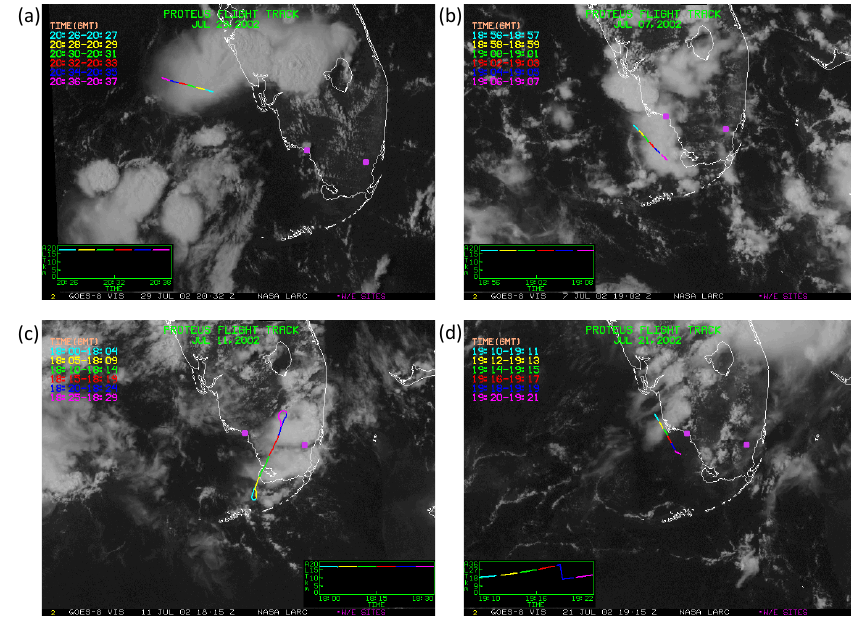
Fig. 2. GOES-8 visible images with Proteus flight track for (a) 29 July; (b) 7 July; (c) 11 July; and (d) 21 July. The magenta dots mark the western and eastern ground sites. On 11 July, the most northern storm in the flight track is investigated in Fig. 10. Plotted Proteus altitude information for 21 July is not correct. Figures courtesy of Patrick Minnis and Louis Nguyen, NASA Langley Research